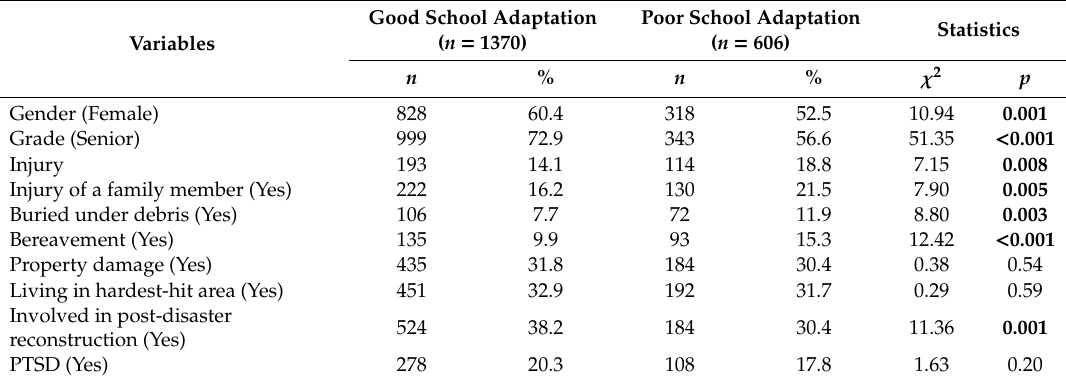
Table 2. Univariate analyses of ASAS among adolescent